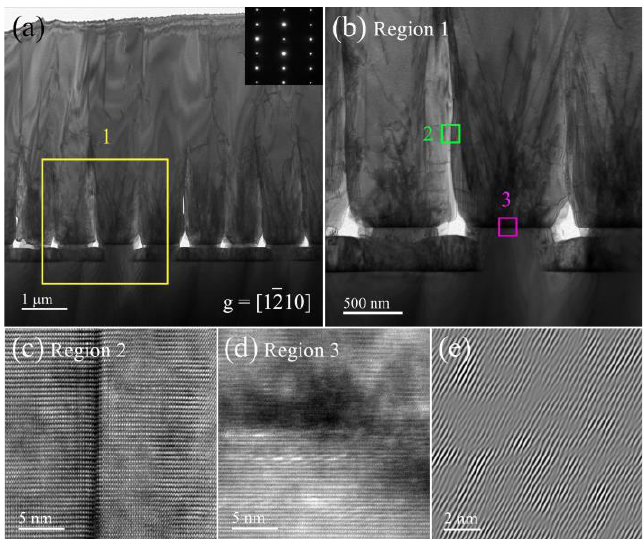
Figure 5b; some dislocations bend or propagate laterally toward free interface before the hole is coalesced, which may be caused by the internal stress. The TDs will preferentially penetrate the areas that are more likely to be exposed. This behavior is beneficial to prevent the TDs propagating to the surface of the film, thus the TDD is effectively reduced. Furthermore, a large fraction of the dislocations is annihilated in the form of fault loops and coalescing dislocations. The decrease in dislocation density is due to the fact that the adjacent dislocations have opposite Burgers vectors forming a loop as the thickness of the epilayer increases [27]. As a result of stress variation near the interface, some TDs could be terminated and not penetrate into the epilayer surface owing to the dislocation line energy minimization [28]. HRTEM measurement is performed to focus on the interface of regions 2 and 3. On the AlN epilayer coalescence interface, we can see the severe lattice mismatch, while dislocations penetrate to the sample surface, as shown in Figure 5c. This is also why the EPD of sample Sp are more likely to be revealed by wet etching. In Figure 5d, the dislocations at the interface are very dense and appear as a black blur, so it is difficult to clearly distinguish the crystal plane. However, by the inverse FFT of Sp interface in Figure 5e, it can be seen that the interface of the nano-patterned substrate has a higher density of misfit dislocations than the flat substrate. The strain could be easily relaxed by the large number of grain boundaries in the hexagonal columnar regions in the process of decreasing temperature, resulting in high-density TDs [29].